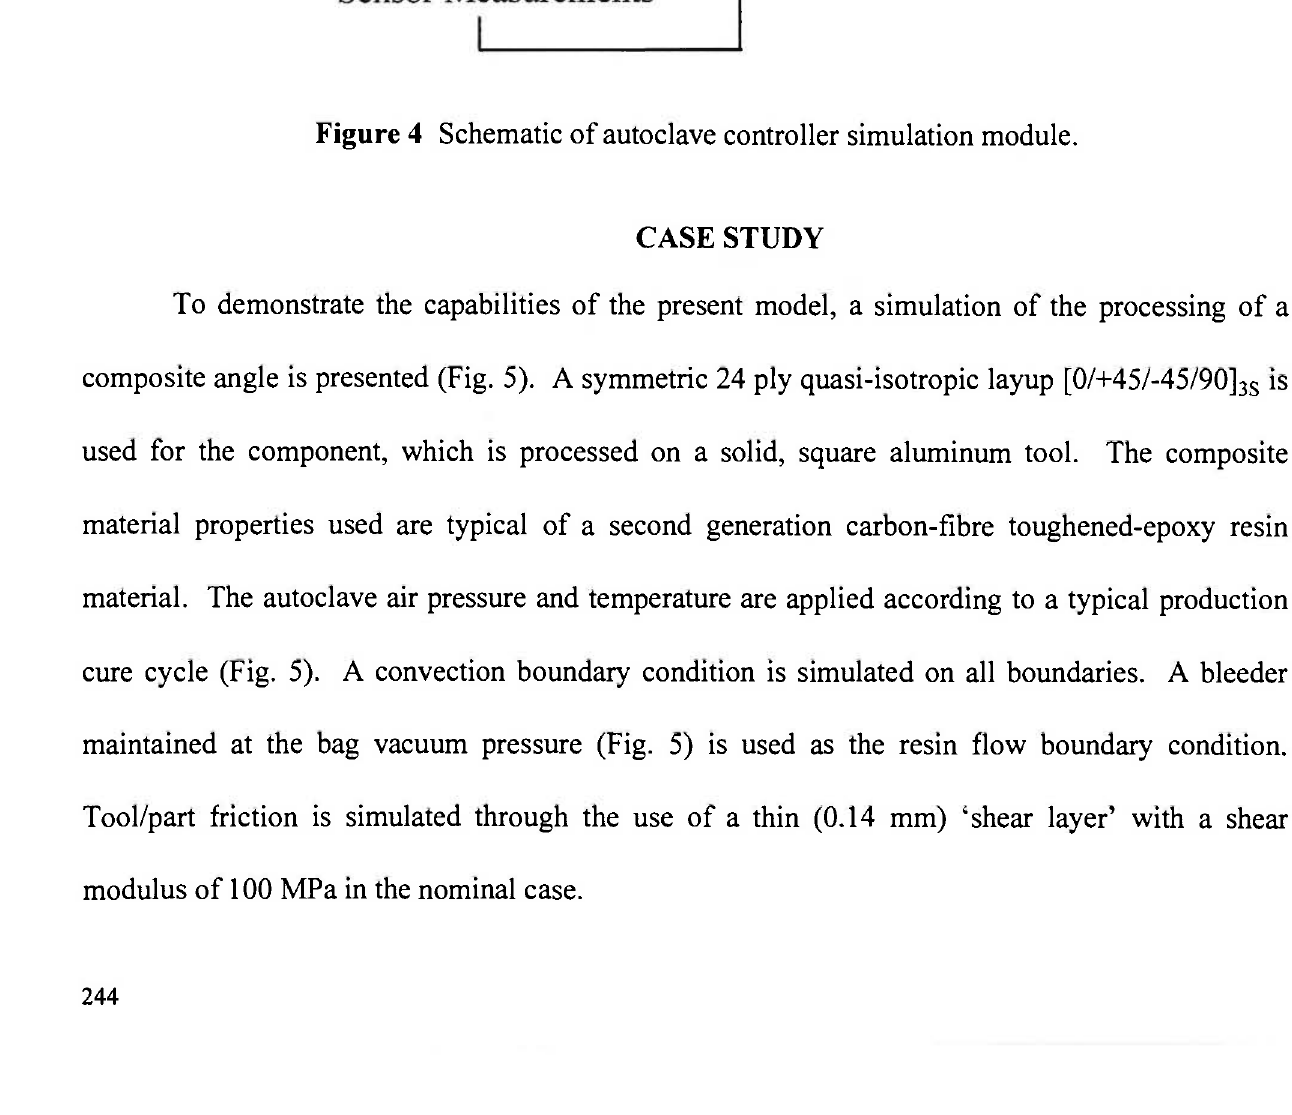
Figure 4 Schematic of autoclave controller simulation